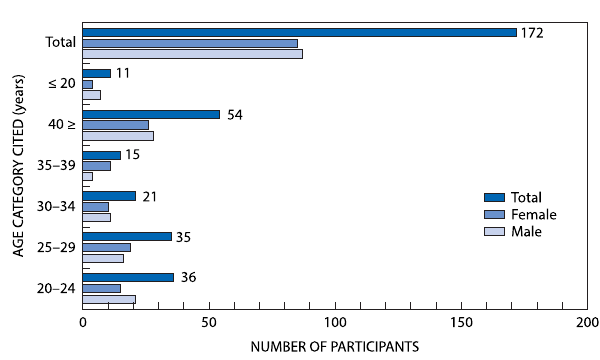
Figure 1: The demographic characteristics of the participants ( n = 172) Table 1a: Other demographic distribution (n = 172) Characteristics